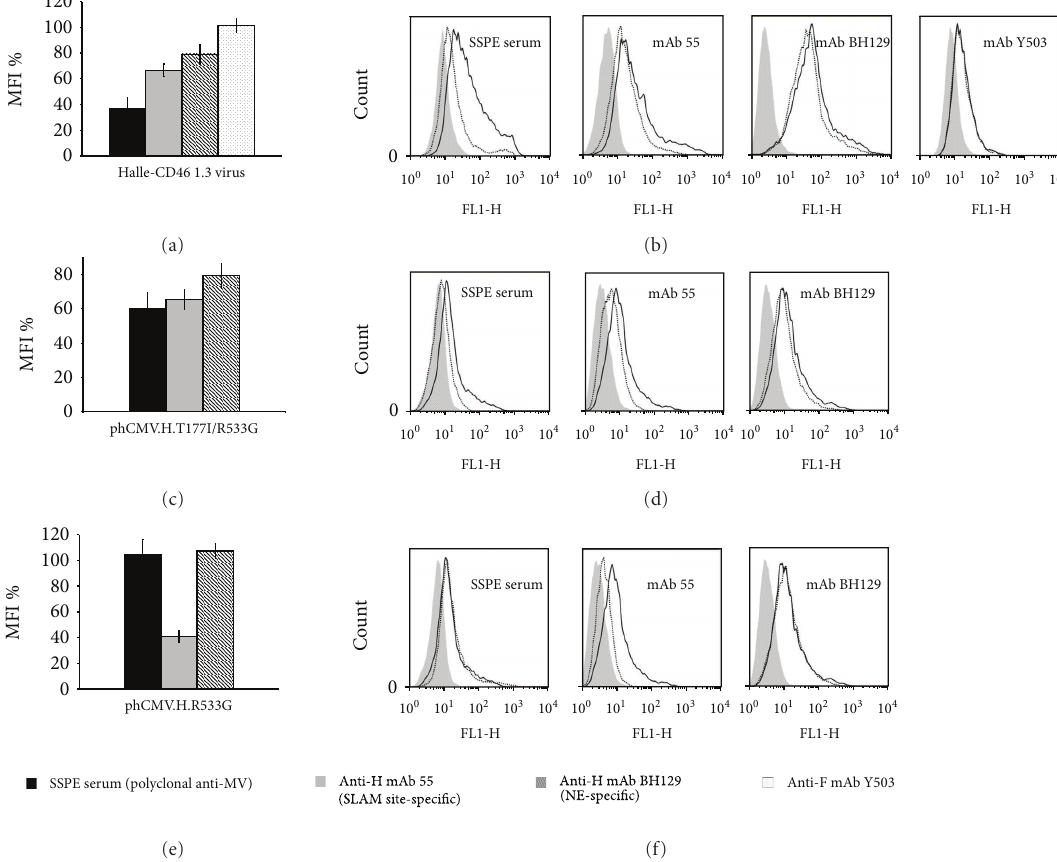
Figure 3: Flow cytometry analysis of escape mutant Halle-CD46 1.3 (H: T177I, R533G; F: no change; M: I69T, I196V). Vero-SLAM cells infected with the escape mutant virus or transfected with phCMV plasmid expressing the mutated H, in the presence of antifusion tri- peptide FIP when necessary, were analysed 1 day after infection (or after transfection) using the indicated antibodies. Each overlay histogram represents one experiment; the MFI histogram data represent the mean percentages ± standard deviations for three experiments. These values were obtained by using nonmutated Halle virus or expressed nonmutated Halle-H protein as controls. (a) and (b)) Escape mutant Halle-CD46 1.3-infected cells; ((c) and (d)) and ((e) and (f)) cells transfected with phCMV.H.T177I/R533G and phCMV.H.R533G,